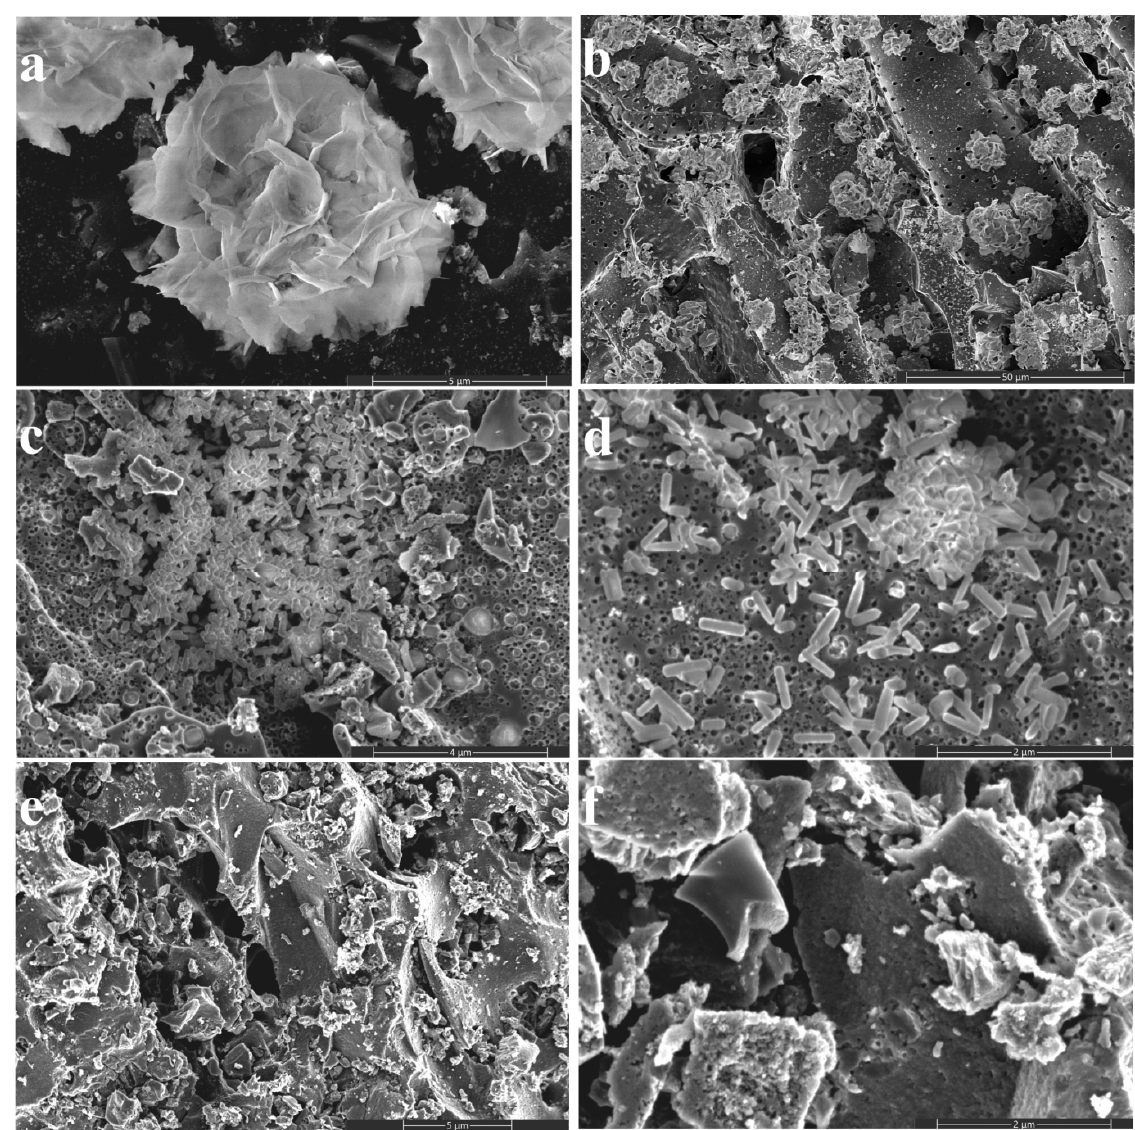
Figure 5. SEM images of BOC/AC_50 ( a ), BOC/AC_100 ( b ), BOC/AC_150 ( c ), BOC/AC_200 ( d ), and activated carbon ( e , f ). Table 1. Surface area, pore volume, and pore diameter of BOC/AC. AC Surface area (m 2